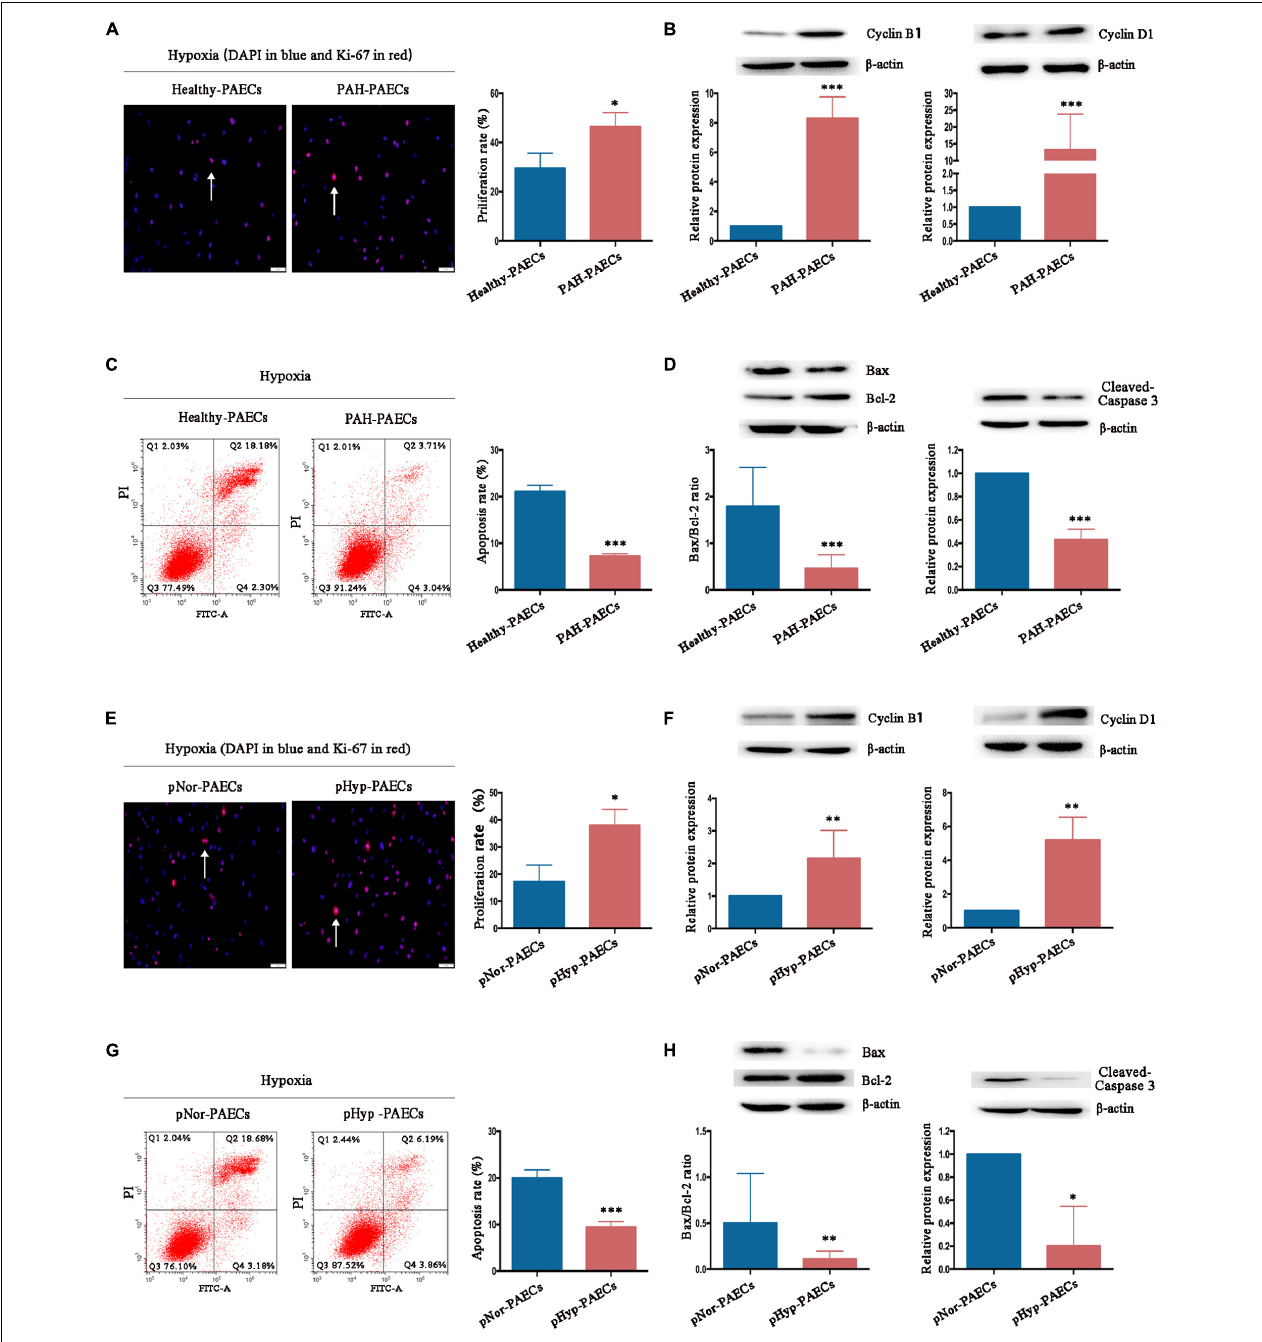
FIGURE 4 | Effect of hypoxia on phenotypes of PAECs. Isolated healthy- or PAH–PAECs were treated with hypoxia (3% O 2 ) for 24 h. Human normal PAECs (hnPAECs) were preconditioned with normoxia (21% O 2 , pNor-PAECs) or hypoxia (3% O 2 , pHyp-PAECs) for 1 week. Then these cells were assessed proliferation and apoptosis by immunofluorescence staining of Ki-67 and flow cytometry under hypoxia (3% O 2 ), respectively. In proliferation assay, Ki-67 positive cells (red) with nuclear DAPI counterstain (blue) indicated the proliferating cells. In apoptosis map, cells were divided into four subpopulations: necrotic cells (Q1: annexin V FITC–/PI+), late apoptotic cells (Q2: annexin V FITC+/PI+), live cells (Q3: annexin V FITC–/PI–), and early apoptotic cells (Q4: annexin V FITC+/PI–). The proliferative (Cyclin B1 and Cyclin D1) and apoptotic factors (Bax, Bcl-2, and cleaved-caspase 3) were detected by Western blot. (A) Immunofluorescence staining of Ki-67 (left part, scale bars = 50 µ m) and the proliferation rate (right part). (B) Expressions of Cyclin B1 and Cyclin D1. (C) Flow cytometry (left part) and the apoptosis rate (right part). (D) Expressions of Bax, Bcl-2, and cleaved caspase 3. (E) Immunofluorescence staining of Ki-67 (left part, scale bars = 50 µ m) and the proliferation rate (right part). (F) Expressions of Cyclin B1 and Cyclin D1. (G) Flow cytometry (left part) and the apoptosis rate (right part). (H) Expressions of Bax, Bcl-2, and cleaved caspase 3. One-way ANOVA test was applied for statistical analysis. Data are represented as mean ± SEM. Experiments were repeated for three independent times. ∗ p < 0.05; ∗∗ p < 0.01; ∗∗∗ p <